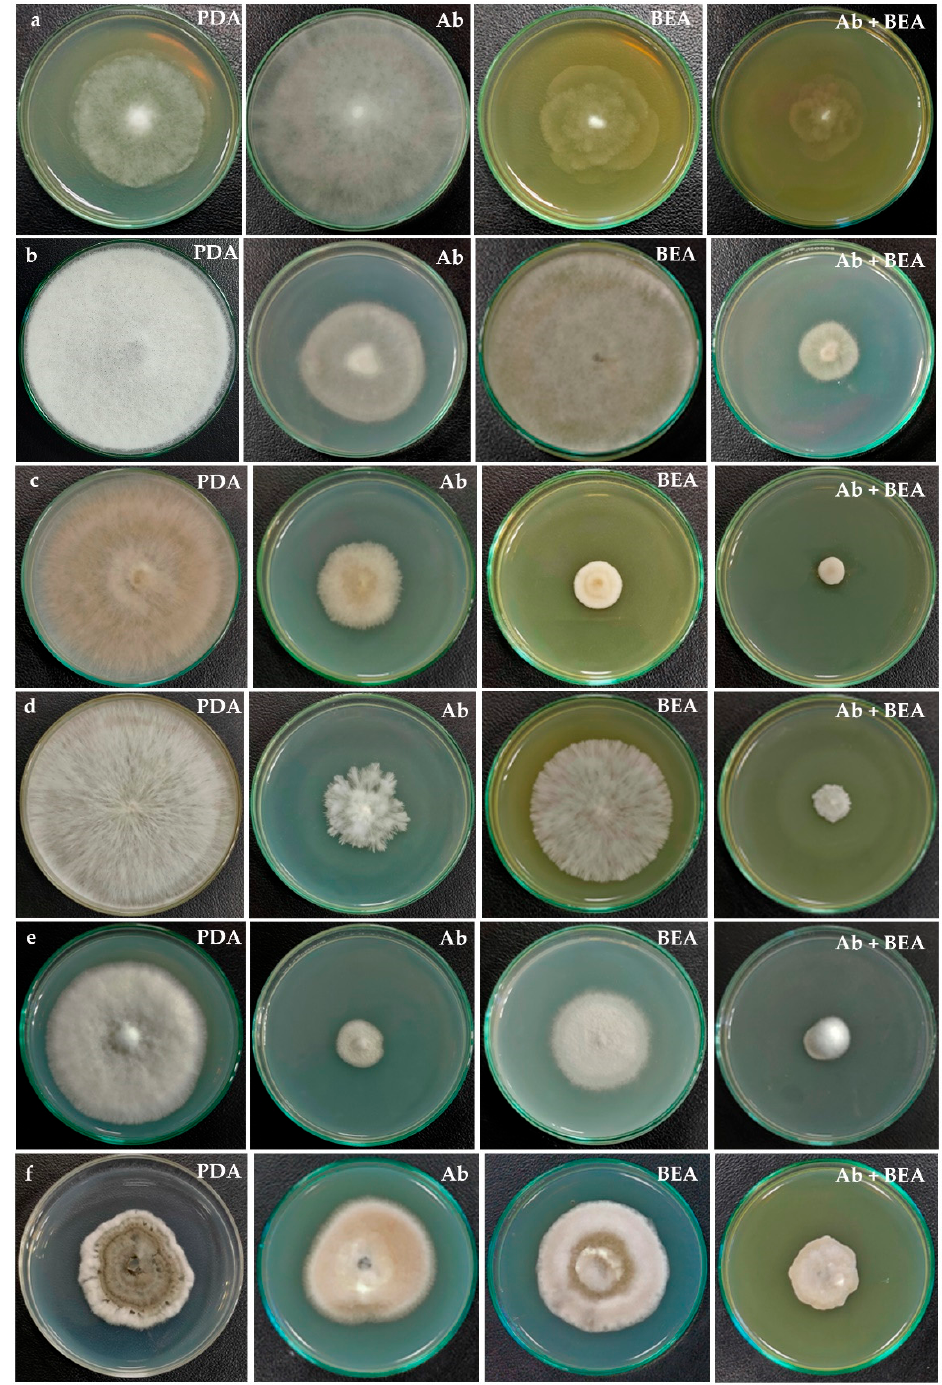
Figure 9. Antifungal activity of individual and combined effect of extract of F . tardicrescens NFCCI 5201 containing beauvericin and amphotericin B on various pathogenic fungi ( a ) Pythium sp. NFCCI 3482 ( b ) Rhizopus sp. NFCCI 2108 ( c ) Rhizoctonia solani NFCCI 4327 ( d ) Sclerotium rolfsii NFCCI 4263 ( e ) Geotrichum candidum NFCCI 3744 ( f ) Bipolaris sorokiniana NFCCI 4690. PDA: Potato dextrose agar (Control); Ab: Potato dextrose agar containing amphotericin B (40 µg/mL); BEA: Potato dextrose agar having extract of F . tardicrescens NFCCI 5201 containing beauvericin (40 µg/mL); Ab + BEA: Potato dextrose agar having amphotericin B (20 µg/mL) and extract of F . tardicrescens NFCCI 5201 containing beauvericin (20 µg/mL).